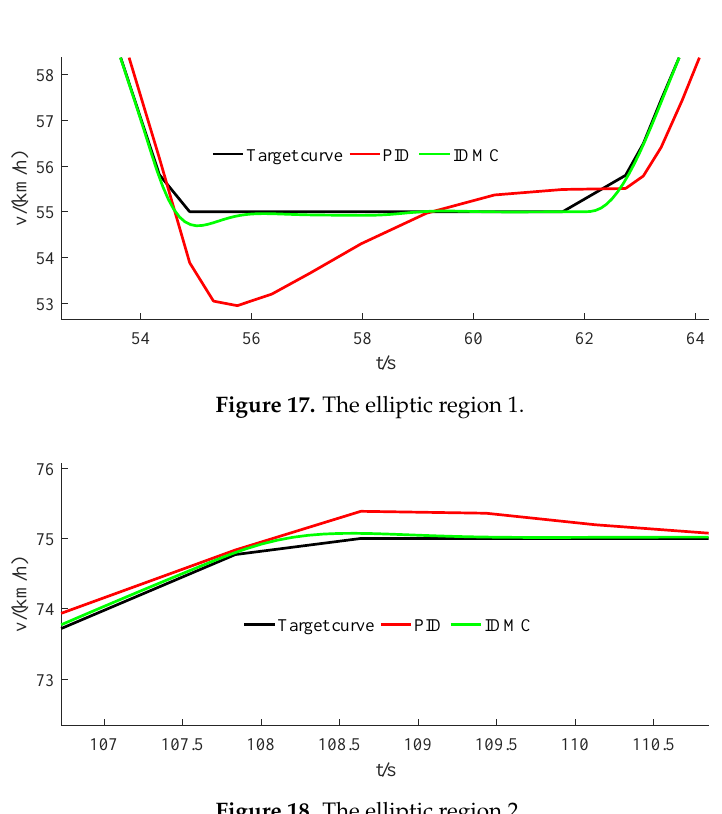
Figure 18. The elliptic region